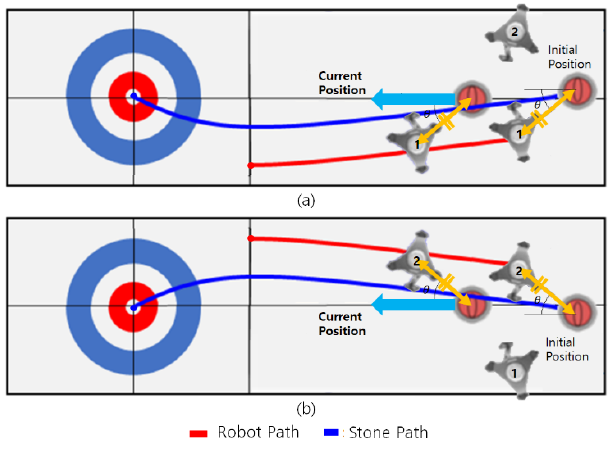
Figure 1. ( a ) Movement of the left sweeper robot. ( b ) Movement of the right sweeper robot.